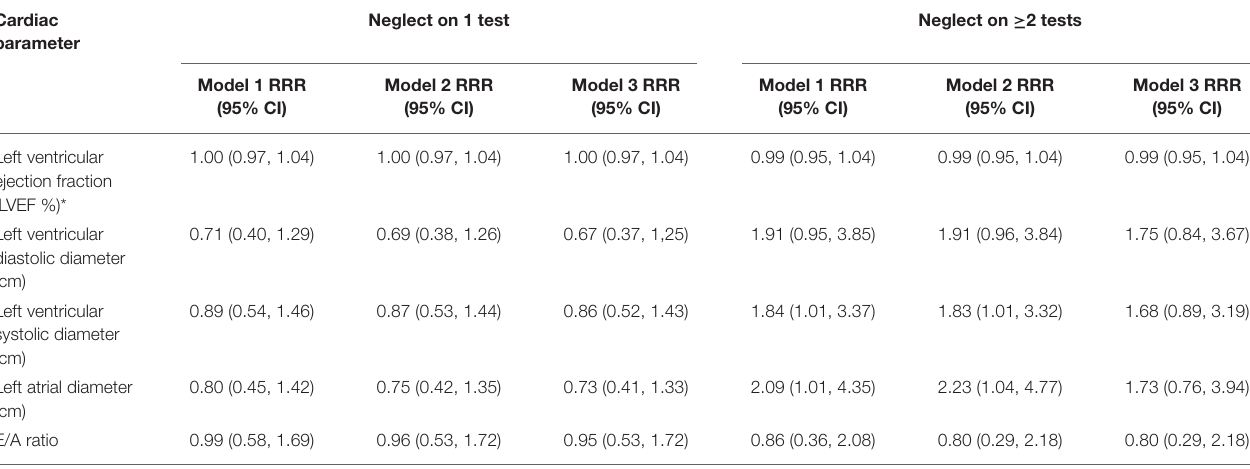
TABLE 3 | Multinomial logistic regression demonstrating the relative risk ratios of neglect, vs. no neglect, per unit increase in the transthoracic echocardiogram variable ( N = 212). Cardiac